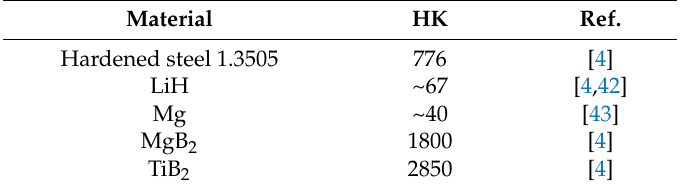
Table 2. Knoop hardness (HK) for the different compounds used in the process. Material HK Ref. Hardened steel